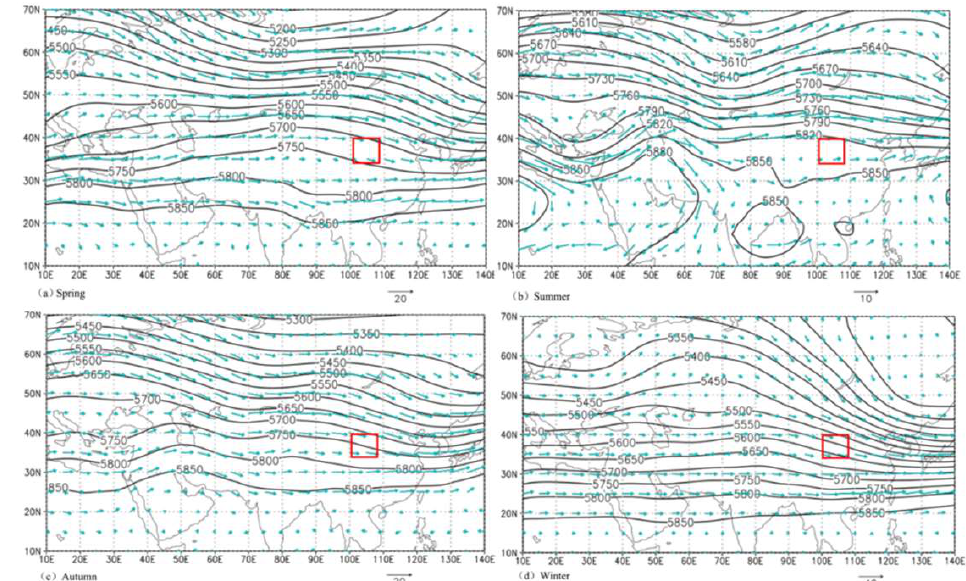
Figure 3. Geopotential height in geopotential meter (gpm) and wind in m/s at 500 hPa in different seasons: ( a ) Spring geopotential height and wind; ( b ) Summer geopotential height and wind; ( c ) Autumn geopotential height and wind; ( d ) Winter geopotential height and wind. Red dashed frames for each subfigure mark the study region.